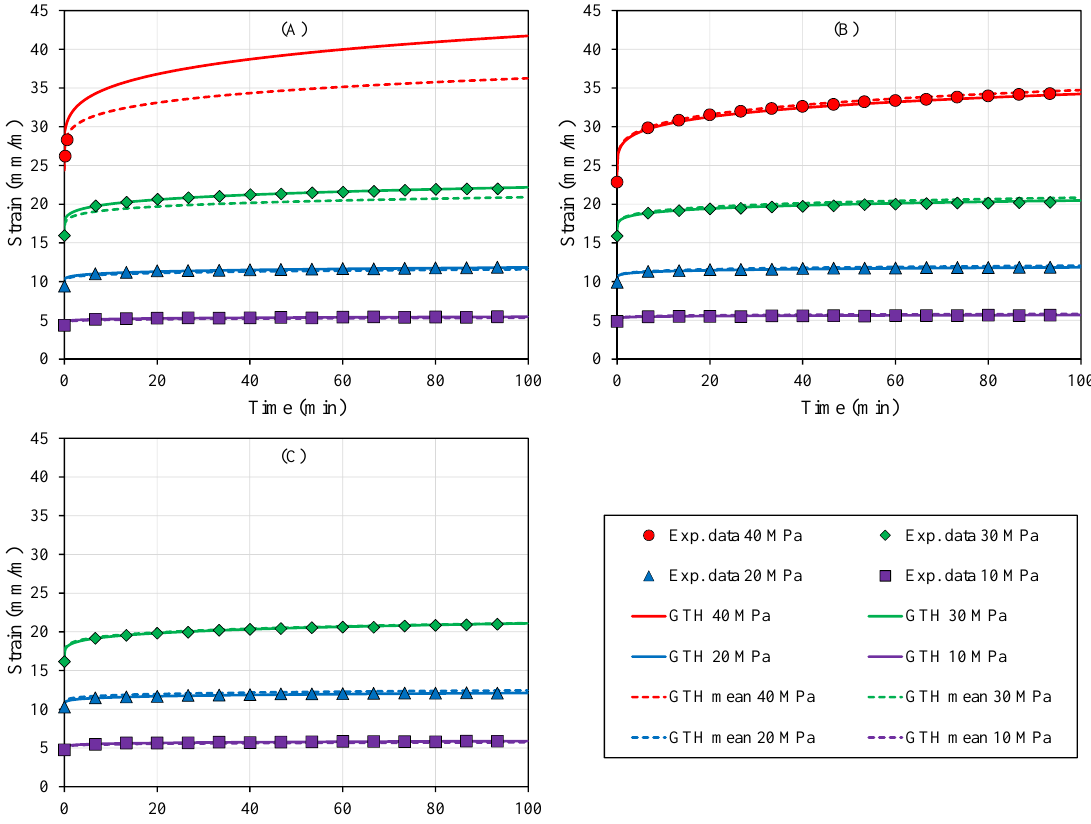
Figure 3. Viscoelastic/plastic curves for different part build orientations at room temperature (RT): ( A ) XY, ( B ) YZ, and ( C ) XZ. The XY and XZ orientations’ specimens broke during the initial loading to 40 MPa. Generalized Time Hardening (GTH) coefficients fitted to each orientation (solid lines) were able to fit creep behavior in all orientations (XY: r = 0.907, p < 0.001; YZ: r = 0.980, p < 0.001; XZ: r = 0.927, p < 0.001), although the averaged GTH coefficients (dashed lines) also provided a reasonable fitting (XY: r = 0.962, p < 0.001; YZ: r = 0.977, p < 0.001; XZ: r = 0.958, p <